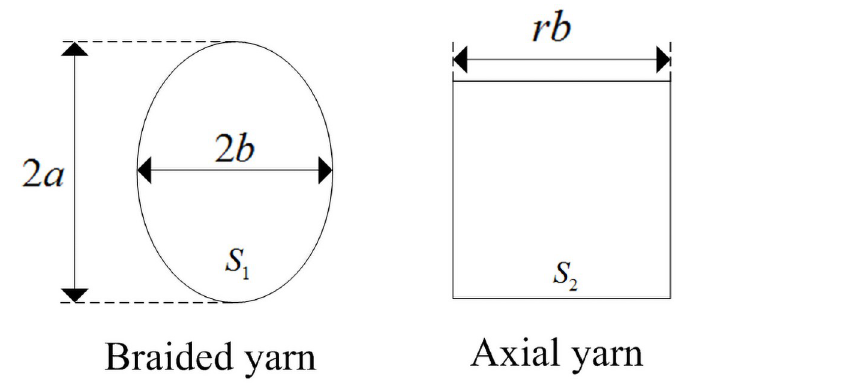
Fig 2. Cross-sectional shape of yarn.